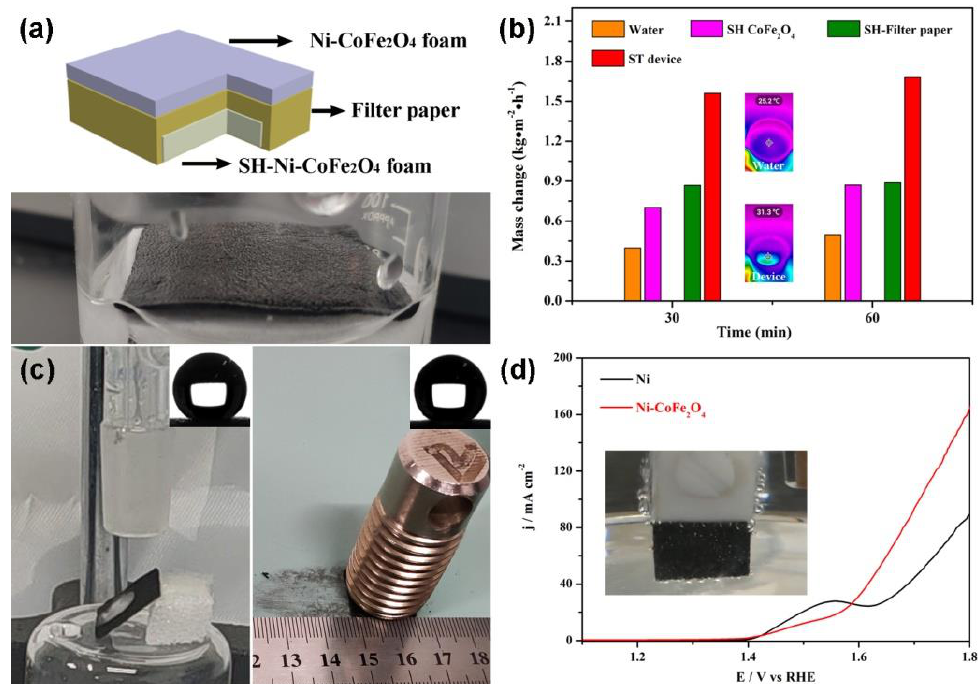
Figure 4. Schematic image of the solar steam device ( a ). Comparative experiment on the velocity of steam production ( b ). Stability test of the superhydrophobic Ni − CoFe 2 O 4 foam ( c ). LSV curves of the CoFe 2 O 4 composites ( d ). The inset of Figure 4b shows the surface temperature of the pure water surface and the device given by the infrared camera. Inset of Figure 4d shows the phenomenon of oxygen production in the working